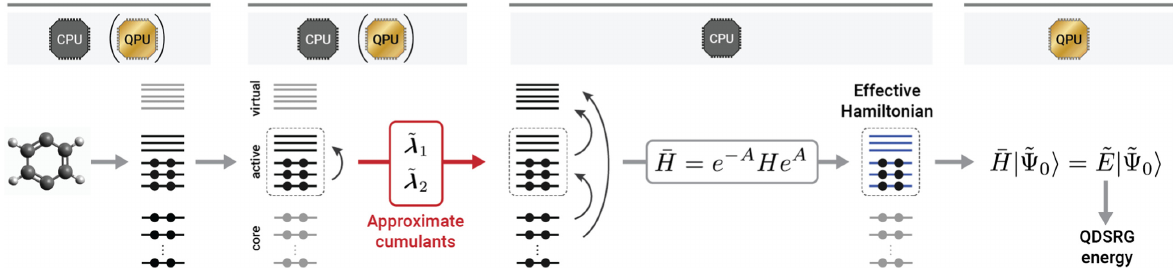
FIG. 1. The QDSRG scheme for performing hybrid quantum classical computations on strongly correlated molecules. The compu- tation begins with a classical or hybrid orbital optimization (1), followed by the preparation of a correlated reference state defined in the subset of active molecular orbitals (2). This step yields the reduced density cumulants ( DSRG algorithm (3) to produce the effective Hamiltonian ( ¯ H 1,2 ) and its expectation value with respect to the approximate cumulants ( (cid:8) ¯ H 1,2 (cid:9) ˜ λ ). In the last step (4), an eigenvalue of the DSRG effective Hamiltonian is found via a quantum algorithm. k